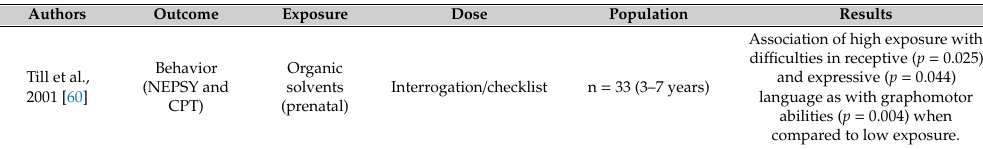
Table 5. Endocrine disruptors and communication